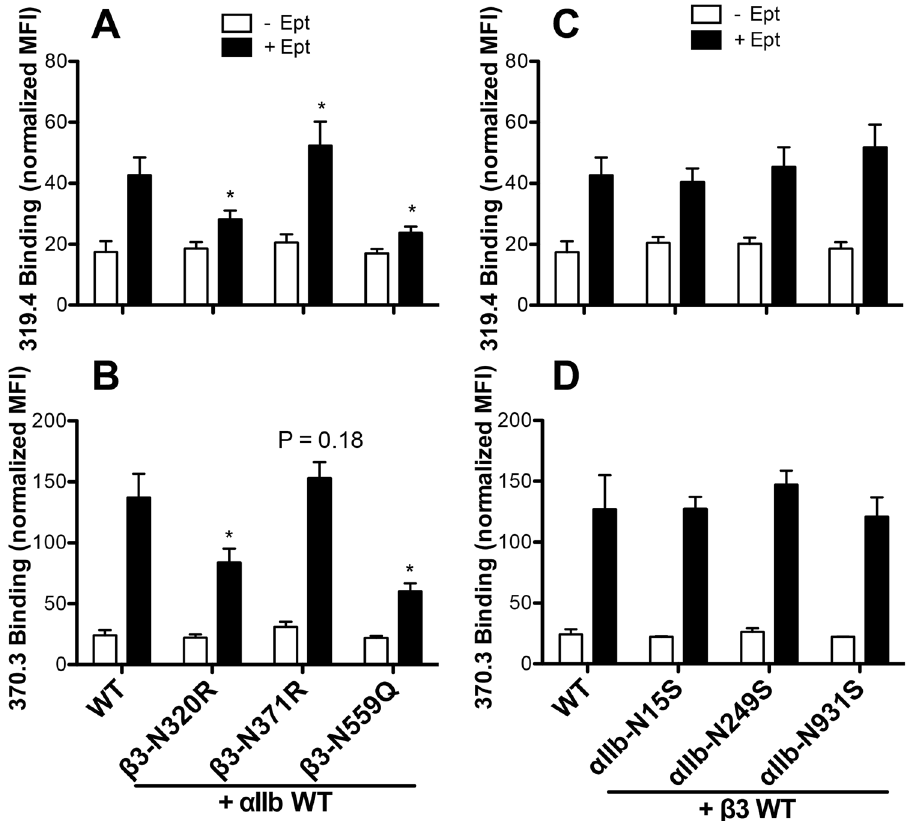
Figure 6. Effect of N-glycan deletions on ligand-induced conformational change of α IIb β 3 integrin. ( A – D) The binding of the active conformation-specific anti- β 3 mAb 319.4 ( A , C ) and the anti- α IIb mAb 370.3 ( B , D ) to the indicated α IIb β 3 constructs expressed in HEK293FT cells in the absence or presence of ligand-mimetic drug eptifibatide (Ept) plus 1 mM Ca 2 + /Mg 2 + . The mAb binding was measured by flow cytometry and presented as a normalized MFI to integrin expression (AP3 binding). Data are means ± s.e.m. (n = 3). Two-tailed t-tests were used to compare the wild type (WT) and the mutants in the same condition. * P <